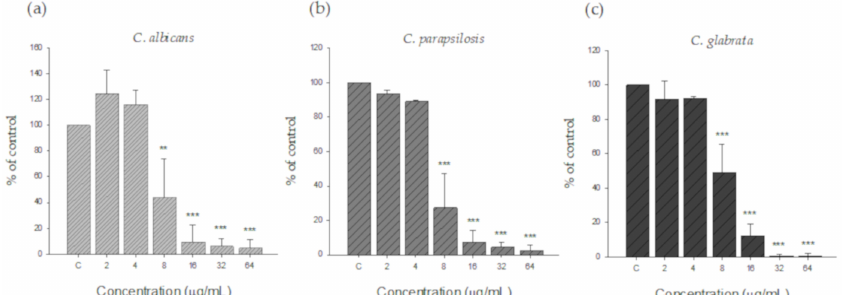
Figure 5. Antifungal activity of AgNPs against ( a ) C. albicans , ( b ) C. parapsilosis , and ( c ) C. glabrata . All species were inoculated at a final density of 0.5–2.5 × 10 3 CFU / mL in RPMI 1640 medium. The silver nanoparticles were prepared at final concentrations ranging from 2 to 64 µ g / mL.